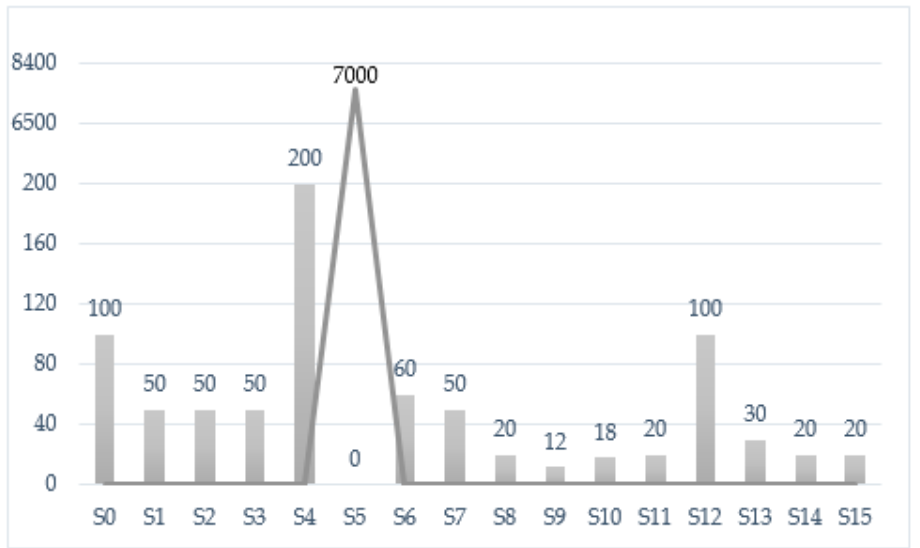
Figure 12. Various effects for C 2 and 16 embedded system layouts.